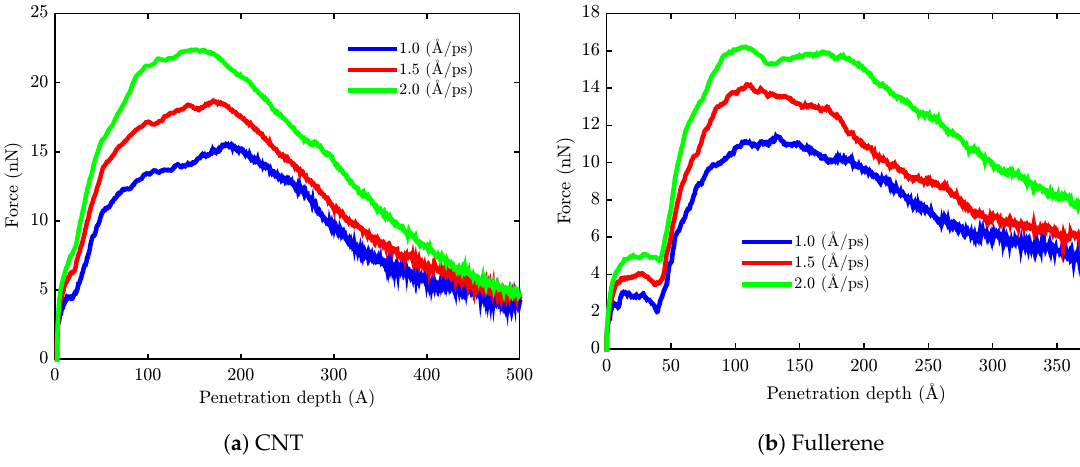
Figure 5. The plot of the average force required for pulling the rod nanocarrier through the bilayer, versus the penetration depth at different velocities.